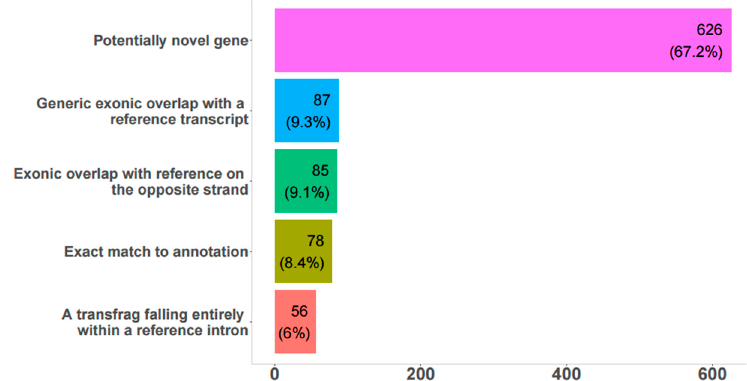
Figure 1. Comparison of detected long non-coding RNAs (lncRNA) to reference genome annotation. Bar graph showing number and percentage of transcripts obtained from FEELnc analysis with low coding potential that belongs to each annotation according to the UMD3.1 reference bovine genome.